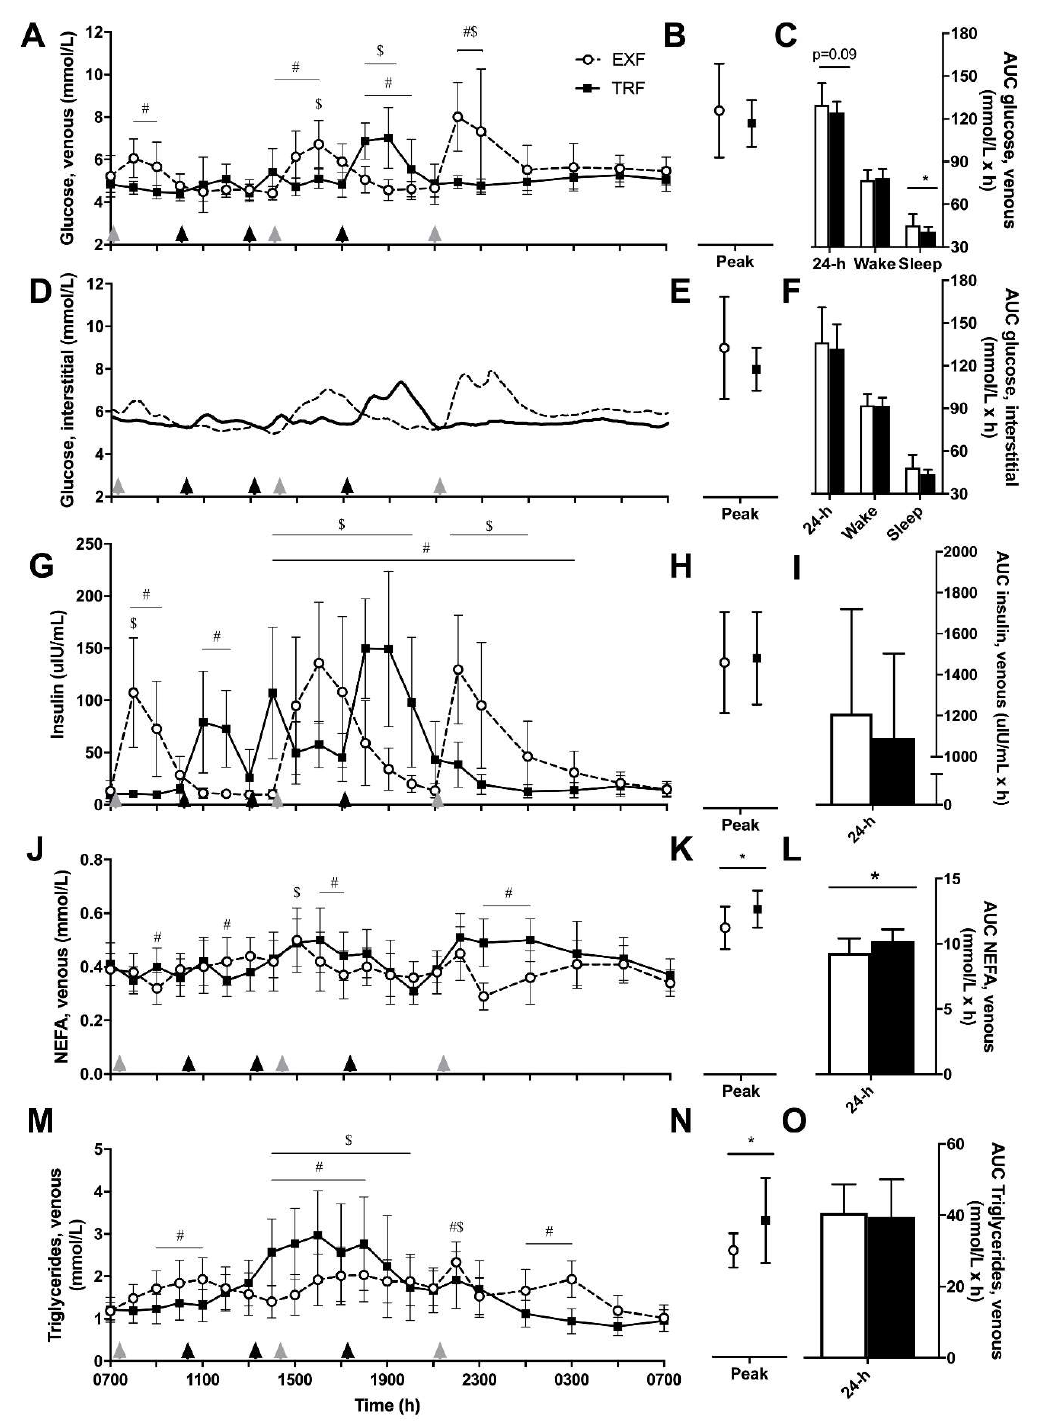
Figure 3. Venous glucose ( A – C ; n = 11), interstitial glucose ( D – F ) and venous insulin ( G – I ), non-esterified fatty acids (NEFA; J – L ), triglyceride ( M – O ) concentrations, peak concentrations and total area under the curve (AUC) values, respectively, from participants with overweight / obesity (n = 10) throughout trial conditions of time-restricted feeding (TRF; black squares and lines) and extended feeding (EXF; white circles and dotted lines). Black triangles represent TRF mealtimes whereas grey triangles represent EXF mealtimes. Data are mean ± SD. p < 0.05 for * main e ff ect of condition; # significantly di ff erent between conditions within time point; $ significantly di ff erent to baseline (0700 h; e ff ect of